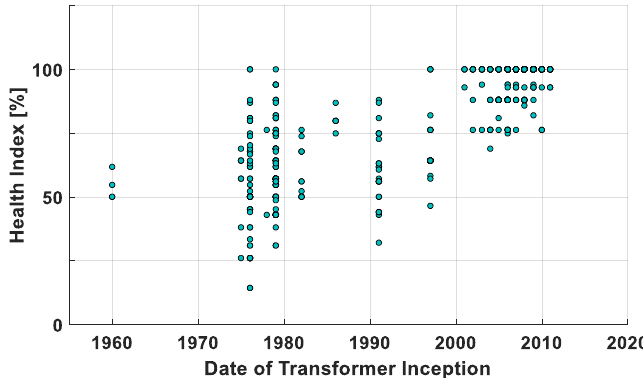
Figure 3. Date of transformer inception versus health index value.